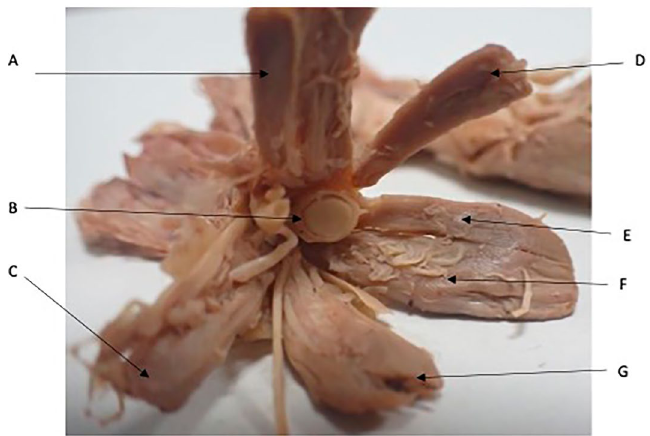
Figure 5. Major (F) and Minor (E) head of the medial rectus. (A) Superior rectus, (B) Optic nerve with surrounding dural sheath, (C) Lateral Rectus, (D) Levator Palpebrae superioris, (G) inferior